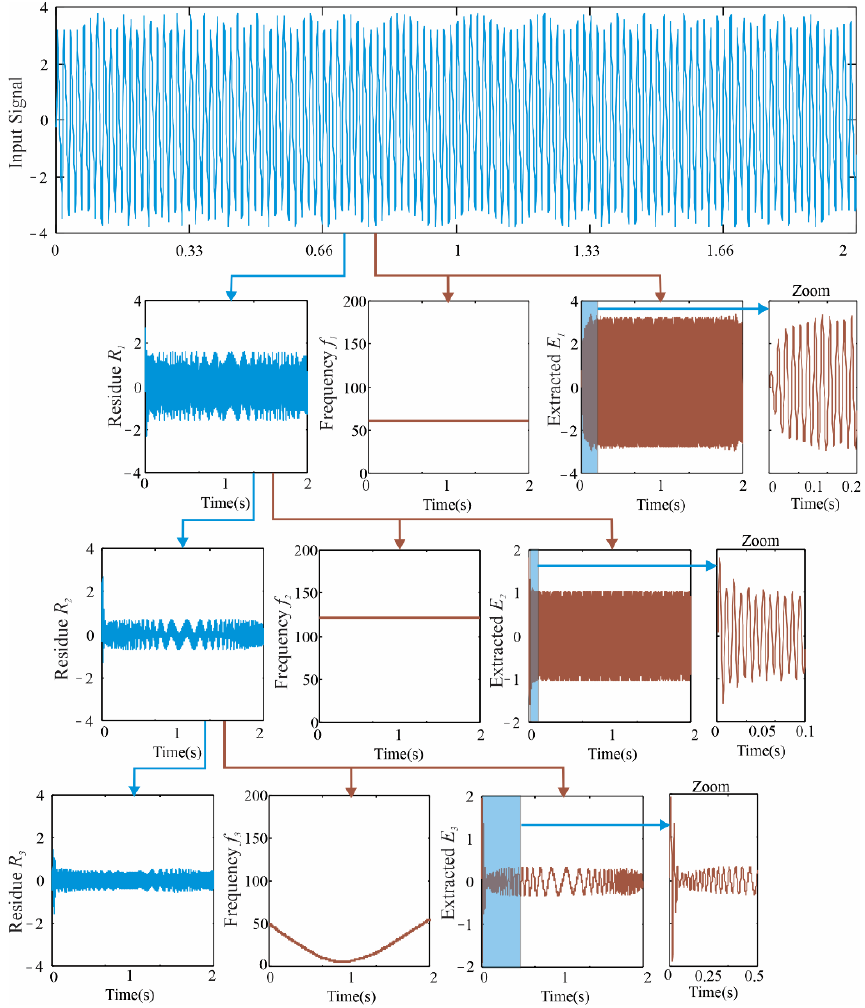
Figure 5. Simulation results for the extraction of three frequency components.